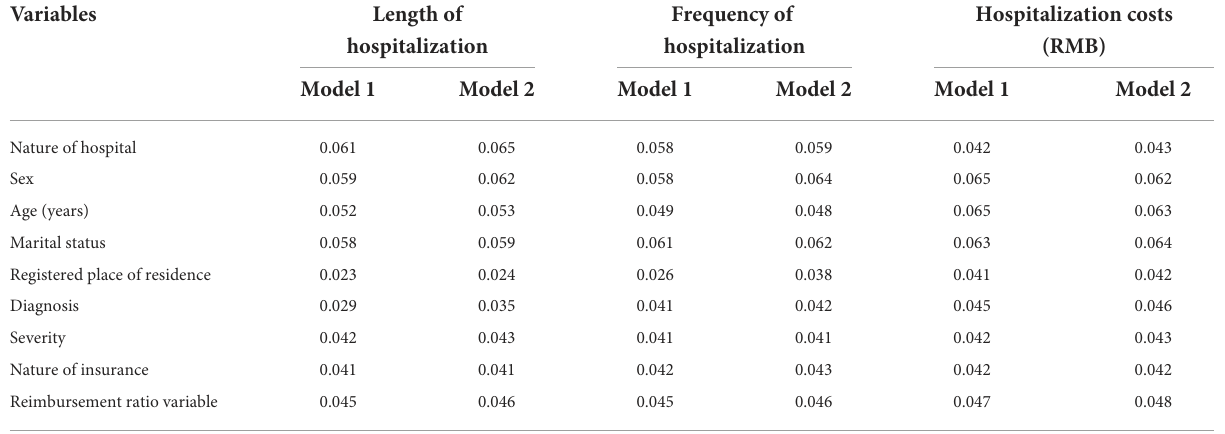
TABLE 10 Multiple regression analysis for disparities in the utilization of mental health